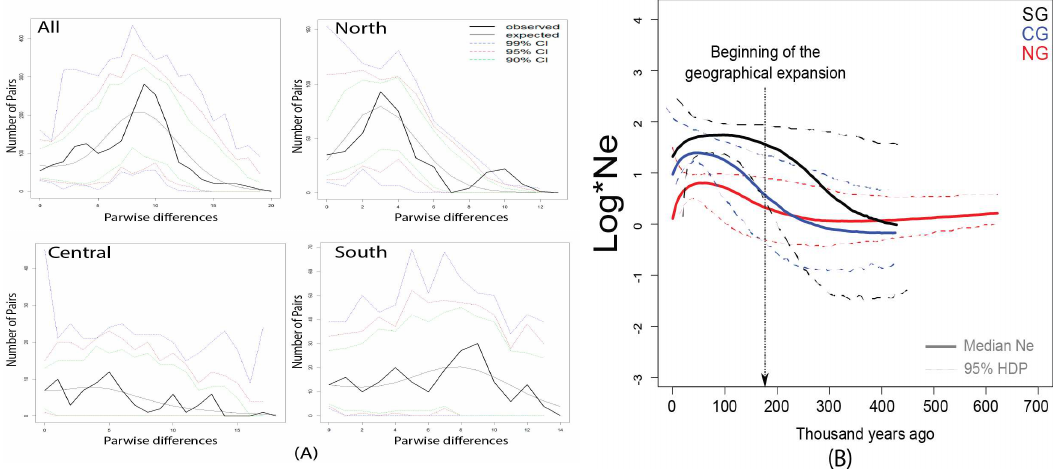
Figure 5. Estimates of demographic expansion in Hydnorobius hydnorae . ( A ) Mismatch distributions for all samples as a single population (ALL) and for each locality group analyzed as a single unit (North, Central, South). To construct the curves of expected values, 10,000 datasets were simulated under a coalescent algorithm using estimated parameters based on a sudden demographic expansion [63]. ( B ) Bayesian skyline plots for all locality groups including confidence intervals. Arrow indicates the time estimate for geographic expansions derived from the Bayesian spatial diffusion analysis.